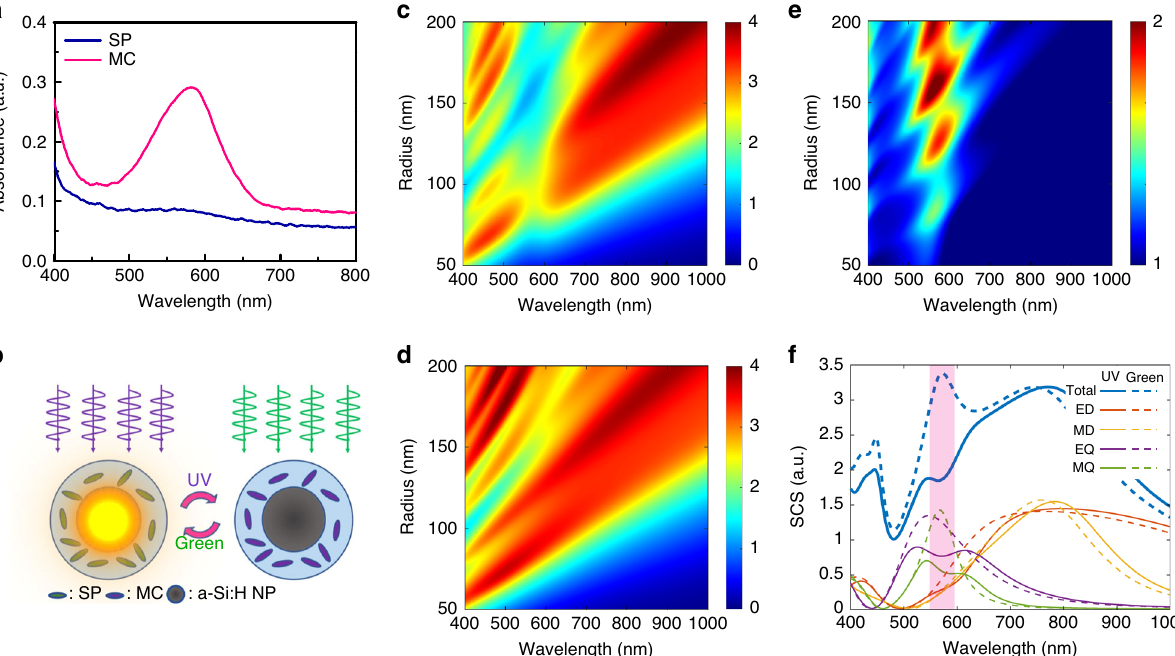
Fig. 3 Designing of the highly tunable photochromic all-dielectric single-particle meta-atom. a Absorption spectra of molecules in SP (blue curve) and MC (pink curve) state. b Schematic representation of the meta-atom consisting of a-Si:H with 40% of hydrogen core and a shell of SP photochromic molecules. The meta-atom is designed to support a strong higher-order Mie resonance at the absorption resonance of the MC state. The photoisomerization from SP to MC state and from MC to SP state is caused by UV and green light excitation, respectively. c , d Scattering cross-section (normalized to geometric) map of a core – shell nanostructure ( c ) after UV modi fi cation, and ( d ) green light recovery as a function of wavelength and a-Si:H nanoparticle radius. e Ratio between scattering cross sections of the core – shell after green light recovery and UV modi fi cation. f Scattering cross section of the core – shell with the Si core radius of 130 nm and its multipole decomposition. Solid lines correspond to the core – shell after UV modi fi cation, dashed lines correspond to the core – shell after green light recovery. The thickness of the PMMA + SP shell is 100